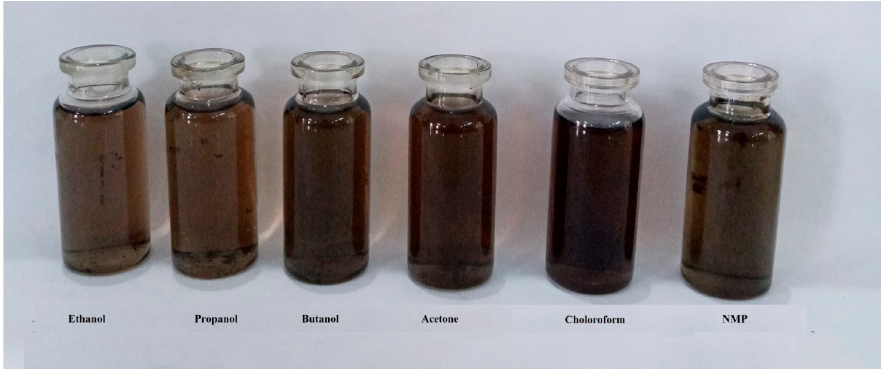
Figure 1. Solution of PDG-g-PANI in different organic solvents as indicated.